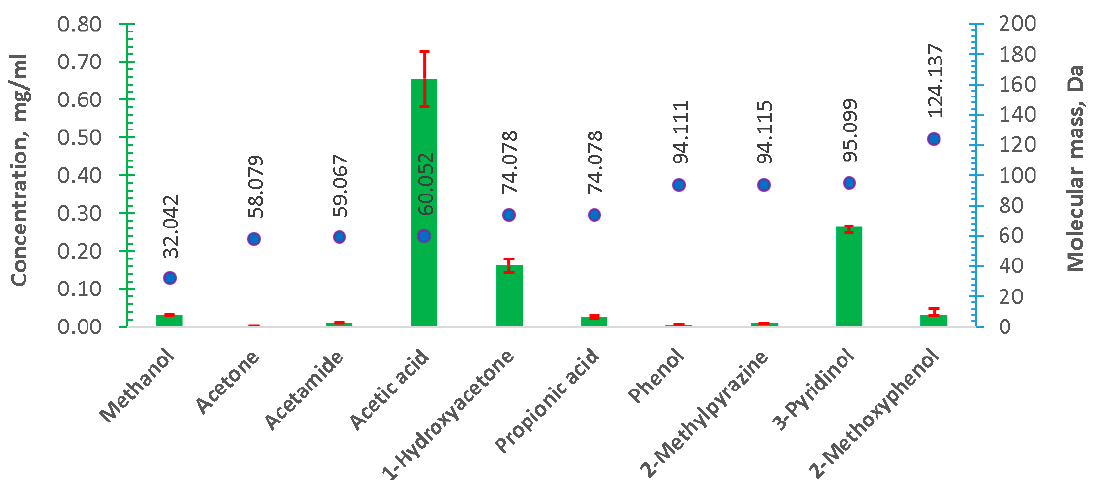
Figure 3. Quantitative results of the GC-MS analysis. Concentration of each compound—bar graph, with the axis on the left-hand side (orange). The molecular mass of detected compound—axis on the right-hand side. Official IUPAC Names and respective masses from the Royal Society of Chemistry database.